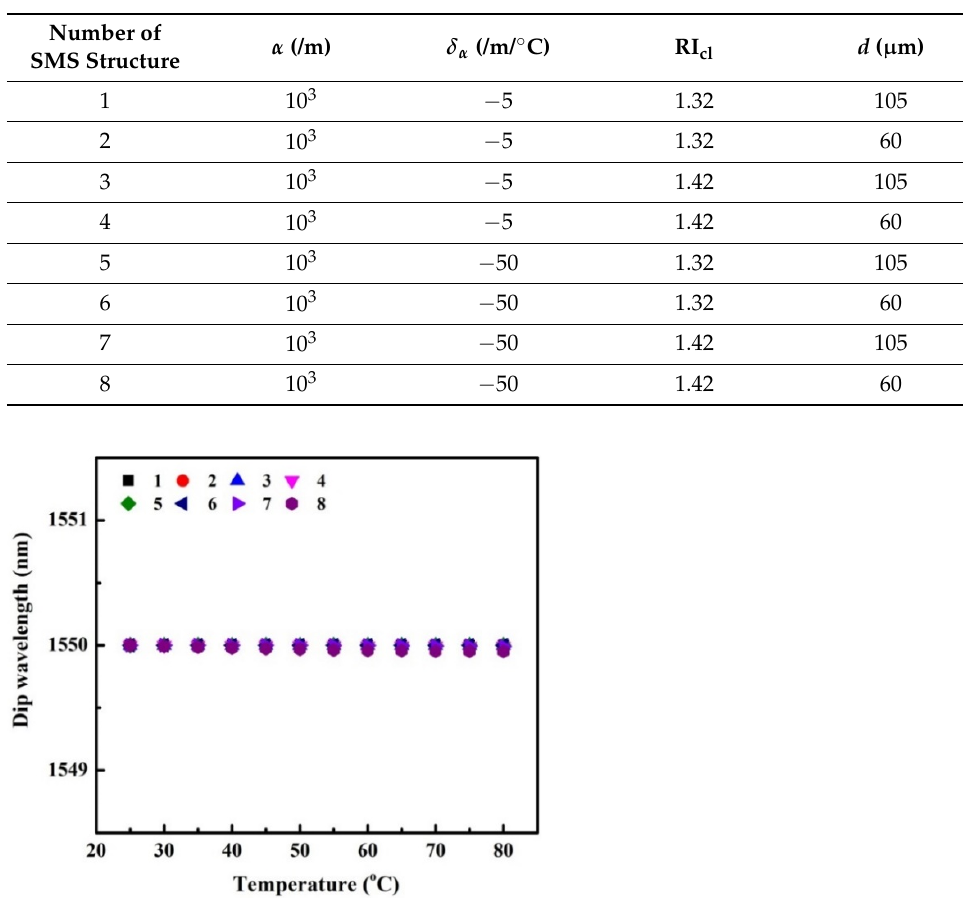
Table 4. Parameters of MMF in the SMS fiber structure.